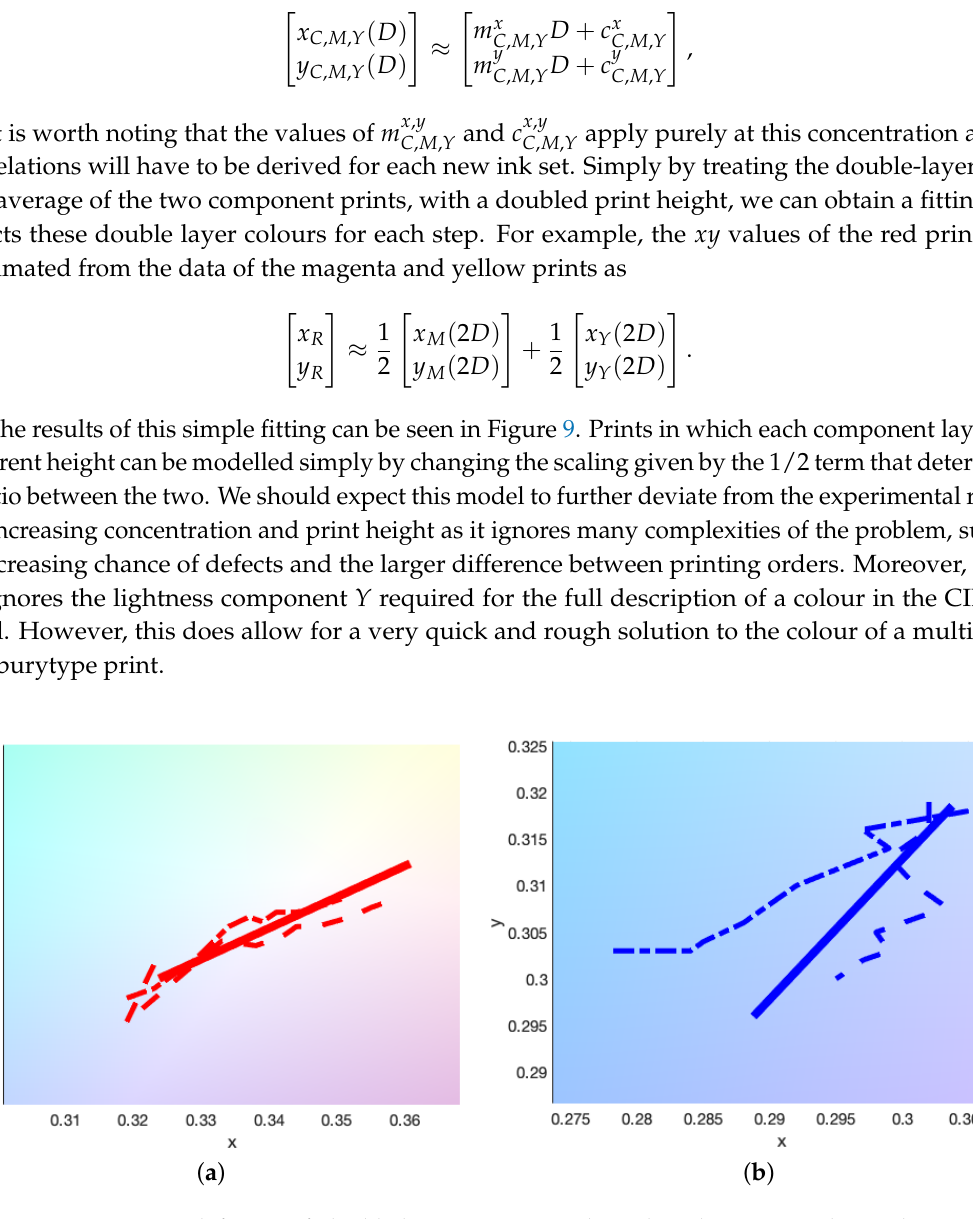
Figure 9. Empirical fitting of double-layer print xy values, based on a simple combination of the constituent colour xy values, for red ( a ) and blue ( b ). The solid line represents the empirical fitting and the two dashed lines represent the data provided by both of the colour combinations (e.g., CM and